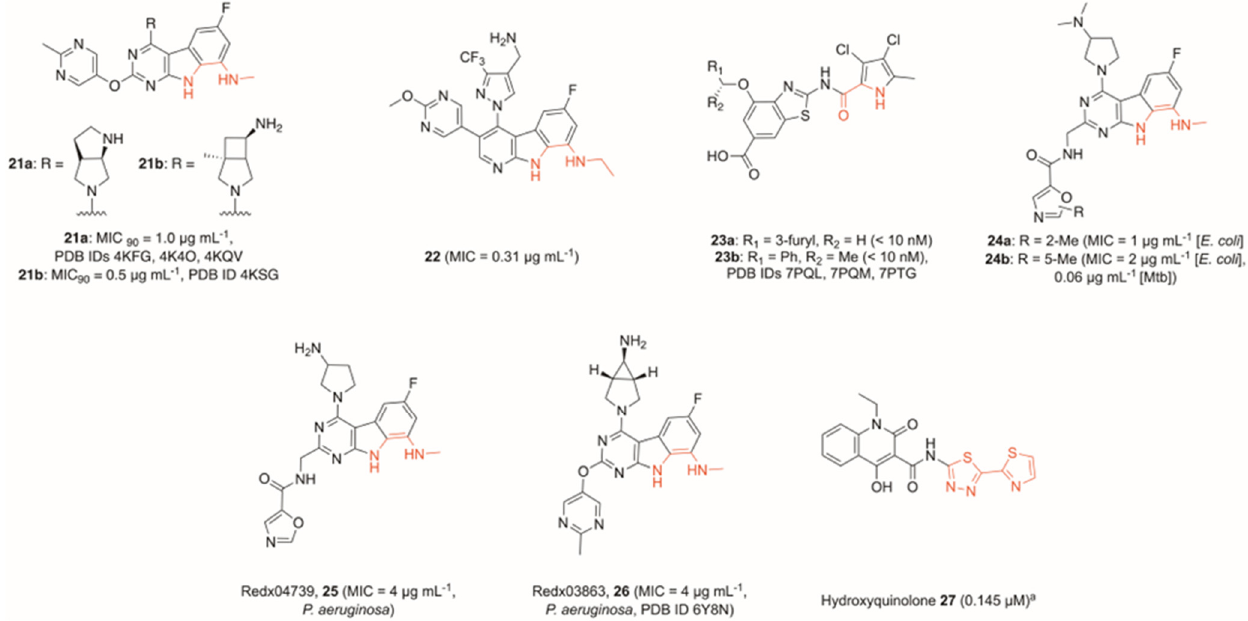
Figure 7. Development of bacterial topoisomerase ATPase inhibitors featuring novel core scaffolds, including tricyclic cores. Motifs binding to a conserved aspartate (red) branched away from the previously identified N -ethyl urea moiety. Values in brackets are IC 50 values measured against E. coli DNA gyrase unless otherwise stated. Although no crystal structures were obtained for many of these compounds, conserved motifs were inferred due to comparisons with successfully crystallised analogues: 22 with PDB IDs 6M1S, 6M1J; 23 with PDB ID 6TTG, 24 – 26 with PDB ID 6Y8N. a No crystal structure of 25 or similar analogues have been obtained, so the key binding atoms were not fully elucidated. As such, the entire thiadiazole ‐ thiazole motif is highlighted to indicate that this region binds to the key aspartate residue, though the exact atoms remain undetermined.